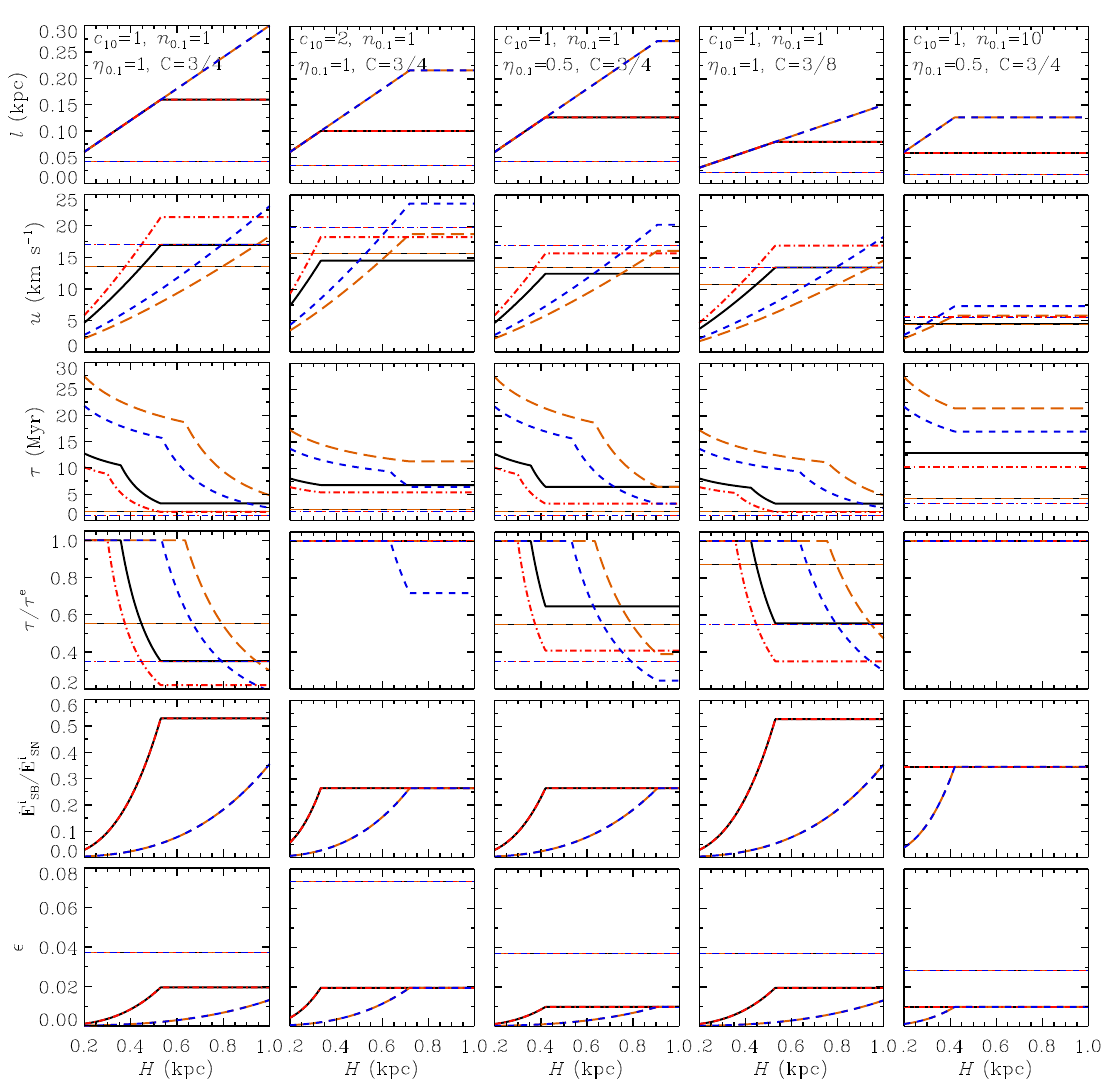
Figure 4. Similar to Figure 3 but showing the cases where all SNe are isolated SNe (thin lines) or all SNe reside in SBs (thick